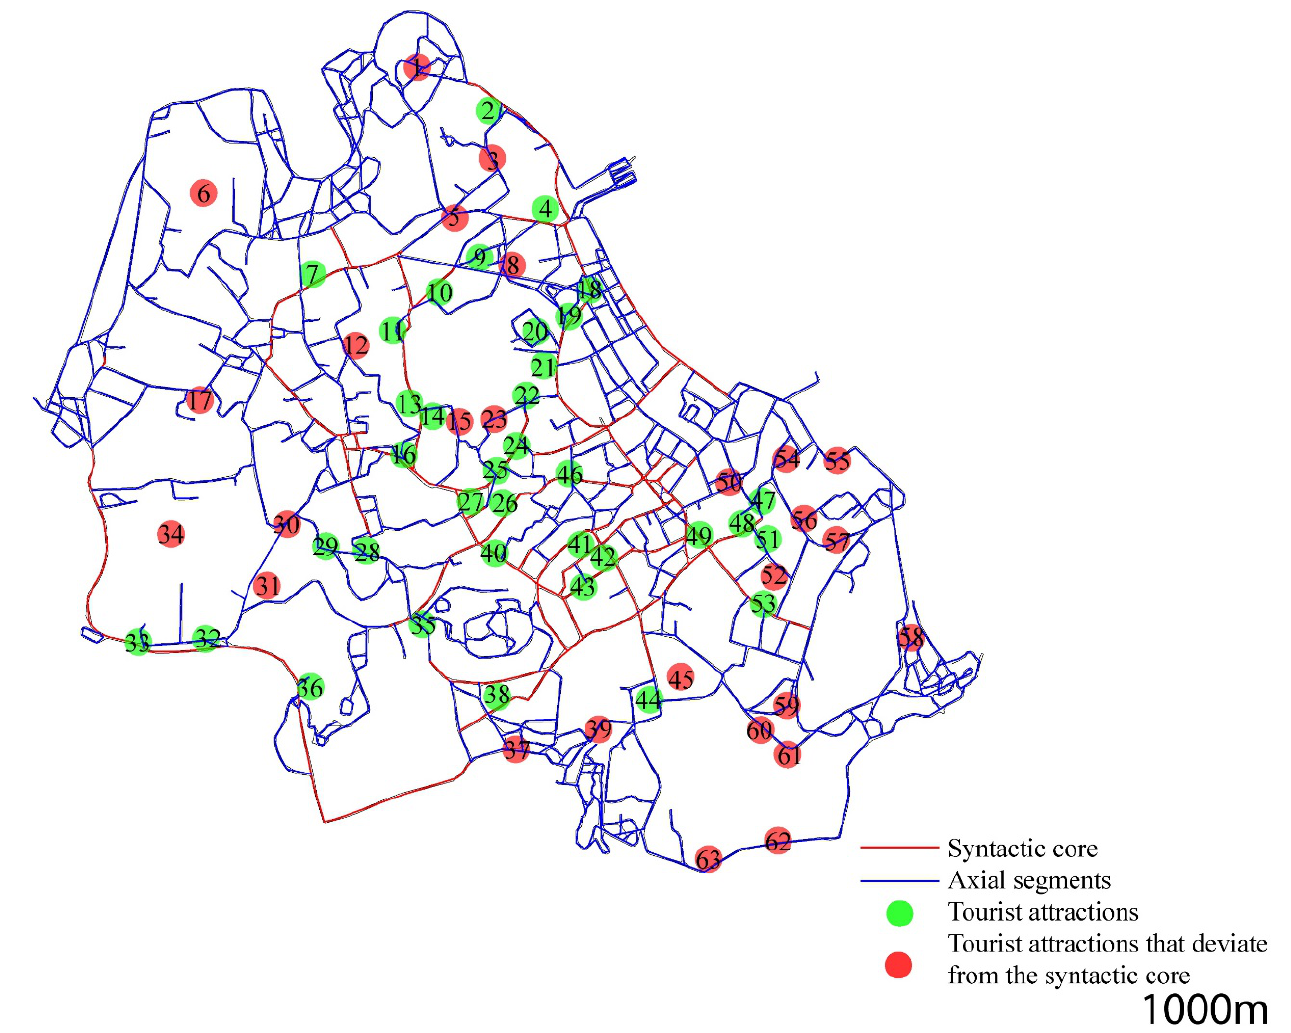
Figure A3. The POI tourist attraction distribution in Kulangsu. The red colour indicates that tourist attractions deviate from the syntactic core of the town.